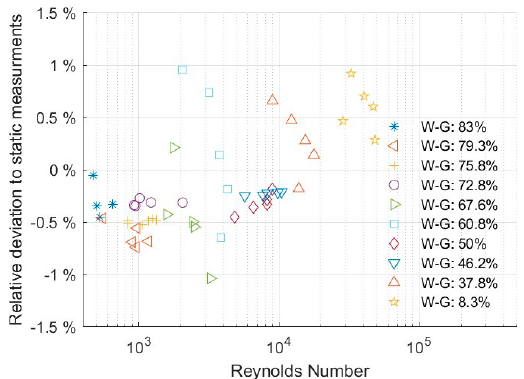
Figure 9. Relative deviation between static and flow measurements in a flow loop for different water–glycerol (W-G) concentrations.